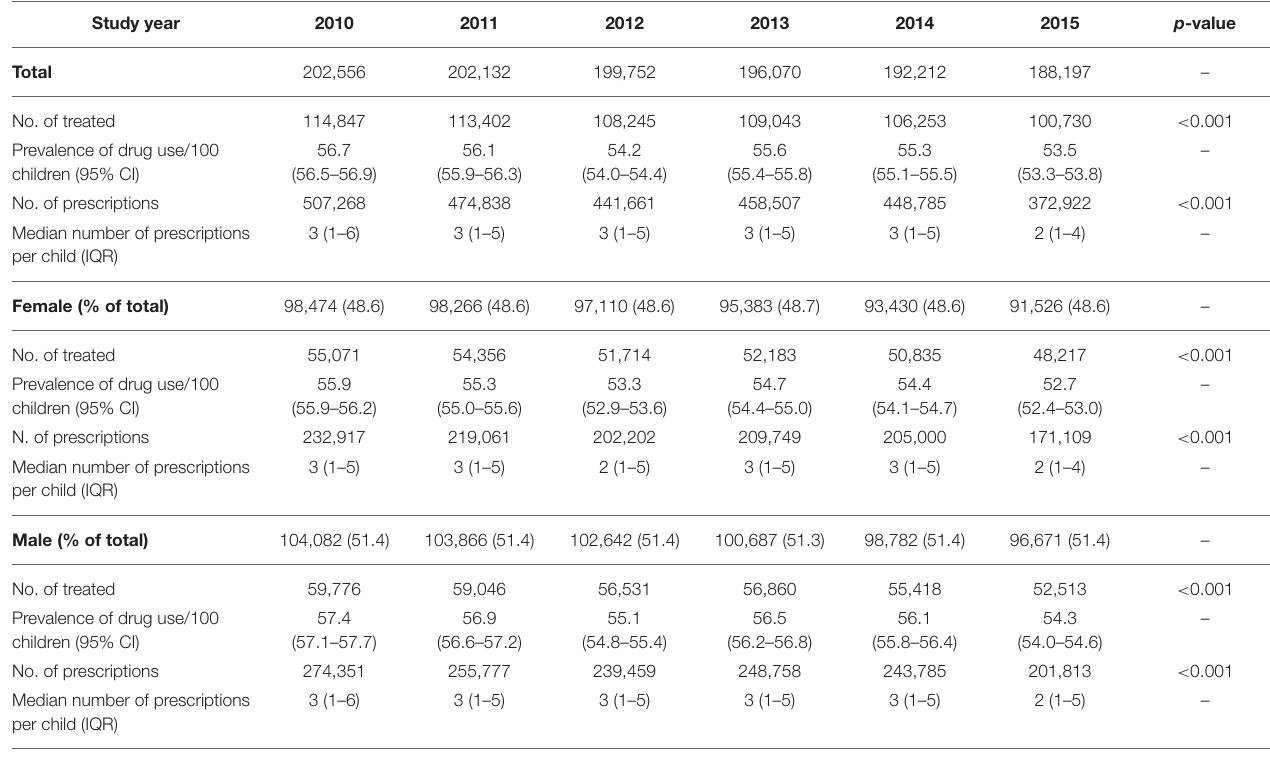
TABLE 1 | Characteristics of the study population and prevalence of drug use per 100 inhabitants during 6 years of observation period.